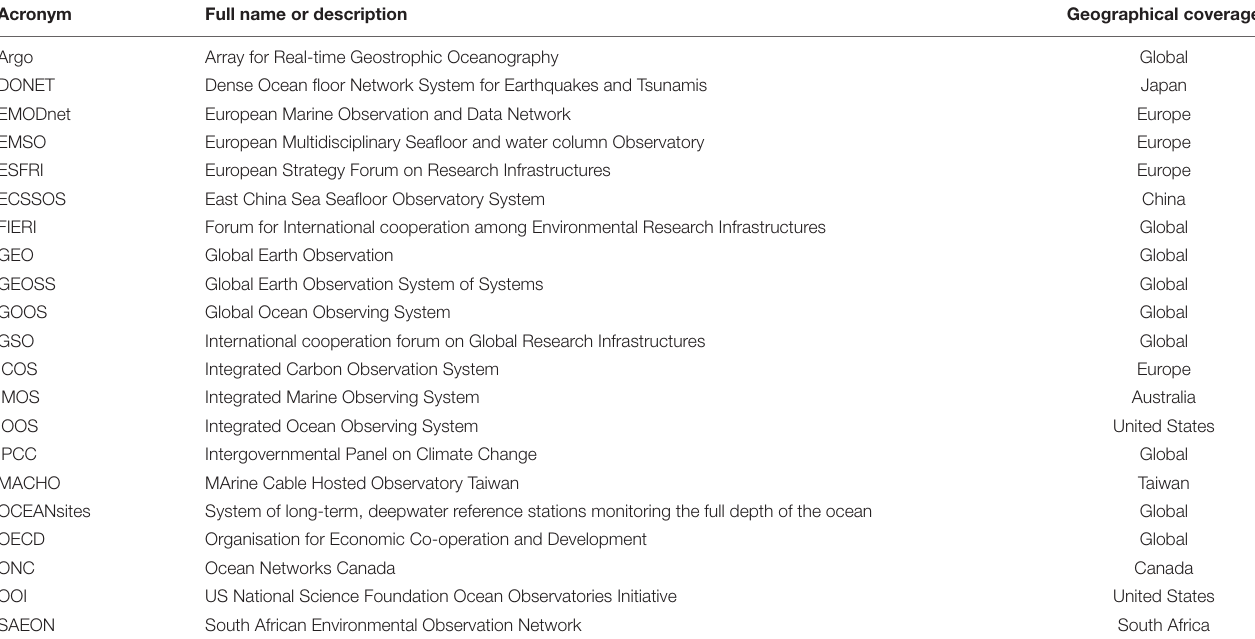
TABLE 1 | Acronym list of RIs and international programs committed to ocean